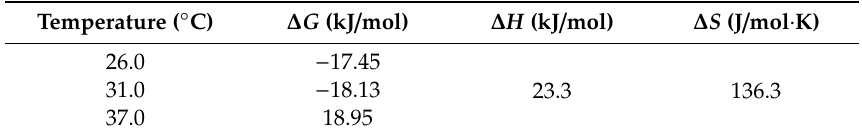
Table 3. Thermodynamic parameters of interaction between physcion and Semen Cassiae